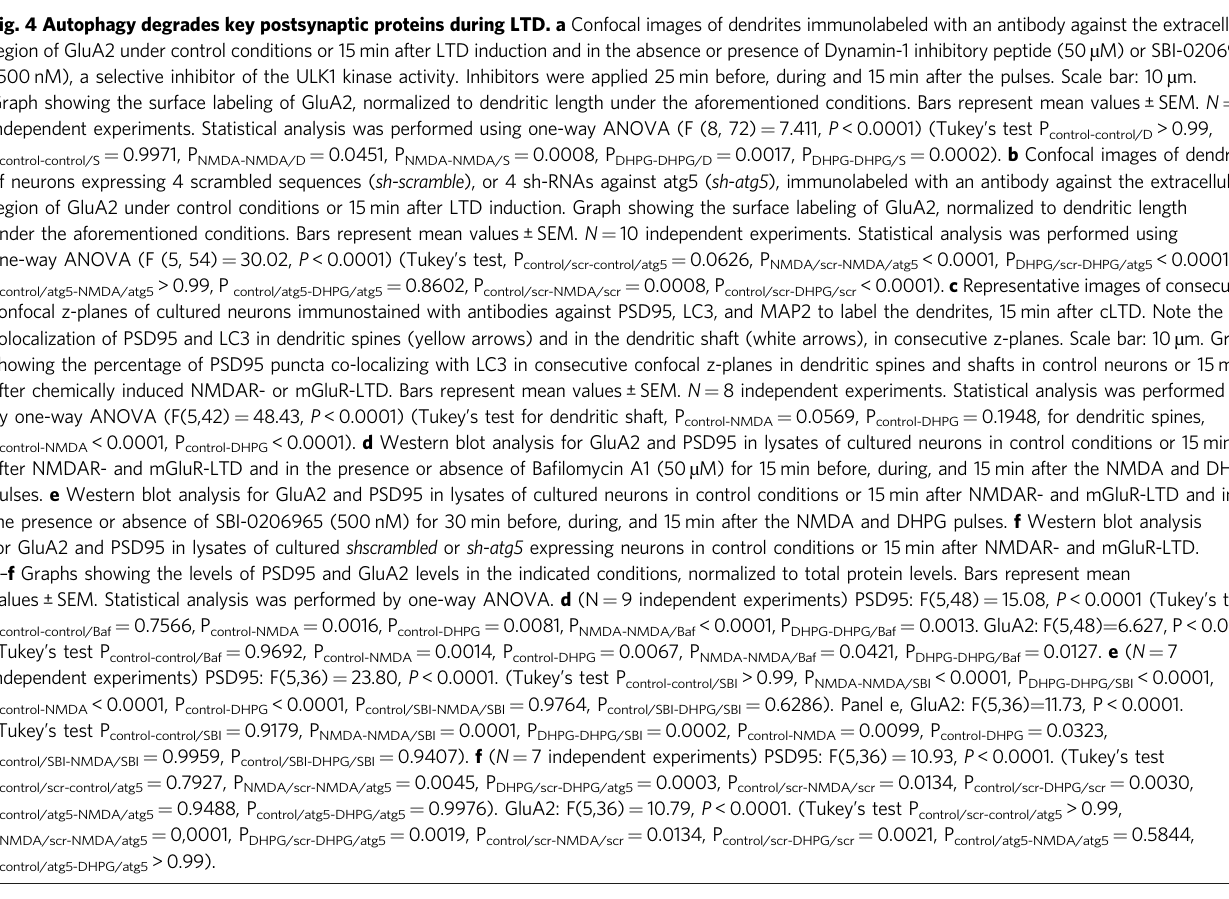
Fig. 4 Autophagy degrades key postsynaptic proteins during LTD. a Confocal images of dendrites immunolabeled with an antibody against the extracellular region of GluA2 under control conditions or 15min after LTD induction and in the absence or presence of Dynamin-1 inhibitory peptide (50 µ M) or SBI-0206965 (500nM), a selective inhibitor of the ULK1 kinase activity. Inhibitors were applied 25min before, during and 15min after the pulses. Scale bar: 10 µ m. Graph showing the surface labeling of GluA2, normalized to dendritic length under the aforementioned conditions. Bars represent mean values±SEM. N = 9 independent experiments. Statistical analysis was performed using one-way ANOVA (F (8, 72) = 7.411, P <0.0001) (Tukey ’ s test P control-control/D >0.99, P control-control/S = 0.9971, P NMDA-NMDA/D = 0.0451, P NMDA-NMDA/S = 0.0008, P DHPG-DHPG/D = 0.0017, P DHPG-DHPG/S = 0.0002). b Confocal images of dendrites of neurons expressing 4 scrambled sequences ( sh-scramble ), or 4 sh-RNAs against atg5 ( sh-atg5 ), immunolabeled with an antibody against the extracellular region of GluA2 under control conditions or 15min after LTD induction. Graph showing the surface labeling of GluA2, normalized to dendritic length under the aforementioned conditions. Bars represent mean values±SEM. N = 10 independent experiments. Statistical analysis was performed using one-way ANOVA (F (5, 54) = 30.02, P <0.0001) (Tukey ’ s test, P control/scr-control/atg5 = 0.0626, P NMDA/scr-NMDA/atg5 <0.0001, P DHPG/scr-DHPG/atg5 <0.0001, P control/atg5-NMDA/atg5 >0.99, P control/atg5-DHPG/atg5 = 0.8602, P control/scr-NMDA/scr = 0.0008, P control/scr-DHPG/scr <0.0001). c Representative images of consecutive confocal z-planes of cultured neurons immunostained with antibodies against PSD95, LC3, and MAP2 to label the dendrites, 15min after cLTD. Note the colocalization of PSD95 and LC3 in dendritic spines (yellow arrows) and in the dendritic shaft (white arrows), in consecutive z-planes. Scale bar: 10 µ m. Graph showing the percentage of PSD95 puncta co-localizing with LC3 in consecutive confocal z-planes in dendritic spines and shafts in control neurons or 15min after chemically induced NMDAR- or mGluR-LTD. Bars represent mean values±SEM. N = 8 independent experiments. Statistical analysis was performed by one-way ANOVA (F(5,42) = 48.43, P <0.0001) (Tukey ’ s test for dendritic shaft, P control-NMDA = 0.0569, P control-DHPG = 0.1948, for dendritic spines, P control-NMDA <0.0001, P control-DHPG <0.0001). d Western blot analysis for GluA2 and PSD95 in lysates of cultured neurons in control conditions or 15min after NMDAR- and mGluR-LTD and in the presence or absence of Ba fi lomycin A1 (50 µ M) for 15min before, during, and 15min after the NMDA and DHPG pulses. e Western blot analysis for GluA2 and PSD95 in lysates of cultured neurons in control conditions or 15min after NMDAR- and mGluR-LTD and in the presence or absence of SBI-0206965 (500nM) for 30min before, during, and 15min after the NMDA and DHPG pulses. f Western blot analysis for GluA2 and PSD95 in lysates of cultured shscrambled or sh-atg5 expressing neurons in control conditions or 15min after NMDAR- and mGluR-LTD. d – f Graphs showing the levels of PSD95 and GluA2 levels in the indicated conditions, normalized to total protein levels. Bars represent mean values±SEM. Statistical analysis was performed by one-way ANOVA. d (N = 9 independent experiments) PSD95: F(5,48) = 15.08, P <0.0001 (Tukey ’ s test P control-control/Baf = 0.7566, P control-NMDA = 0.0016, P control-DHPG = 0.0081, P NMDA-NMDA/Baf <0.0001, P DHPG-DHPG/Baf = 0.0013. GluA2: F(5,48) = 6.627,